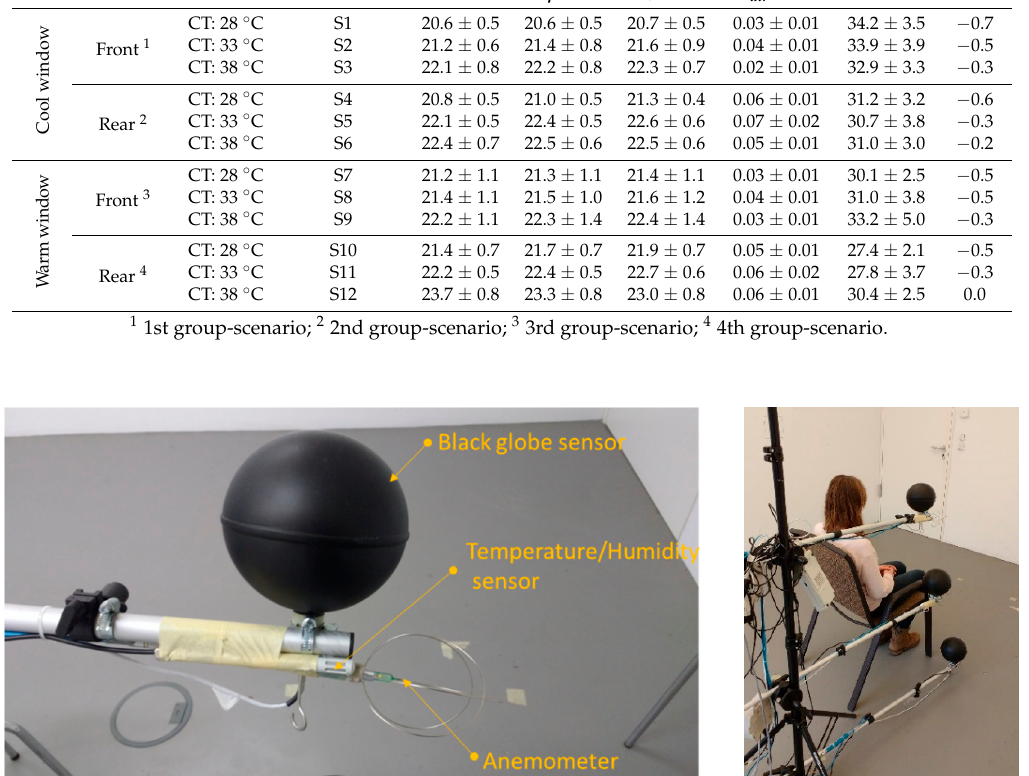
Table 3. Mean values and standard deviations (mean ± sd) of the measured indoor environmental parameters at the height of 110 cm. CT stands for the ceiling temperature.